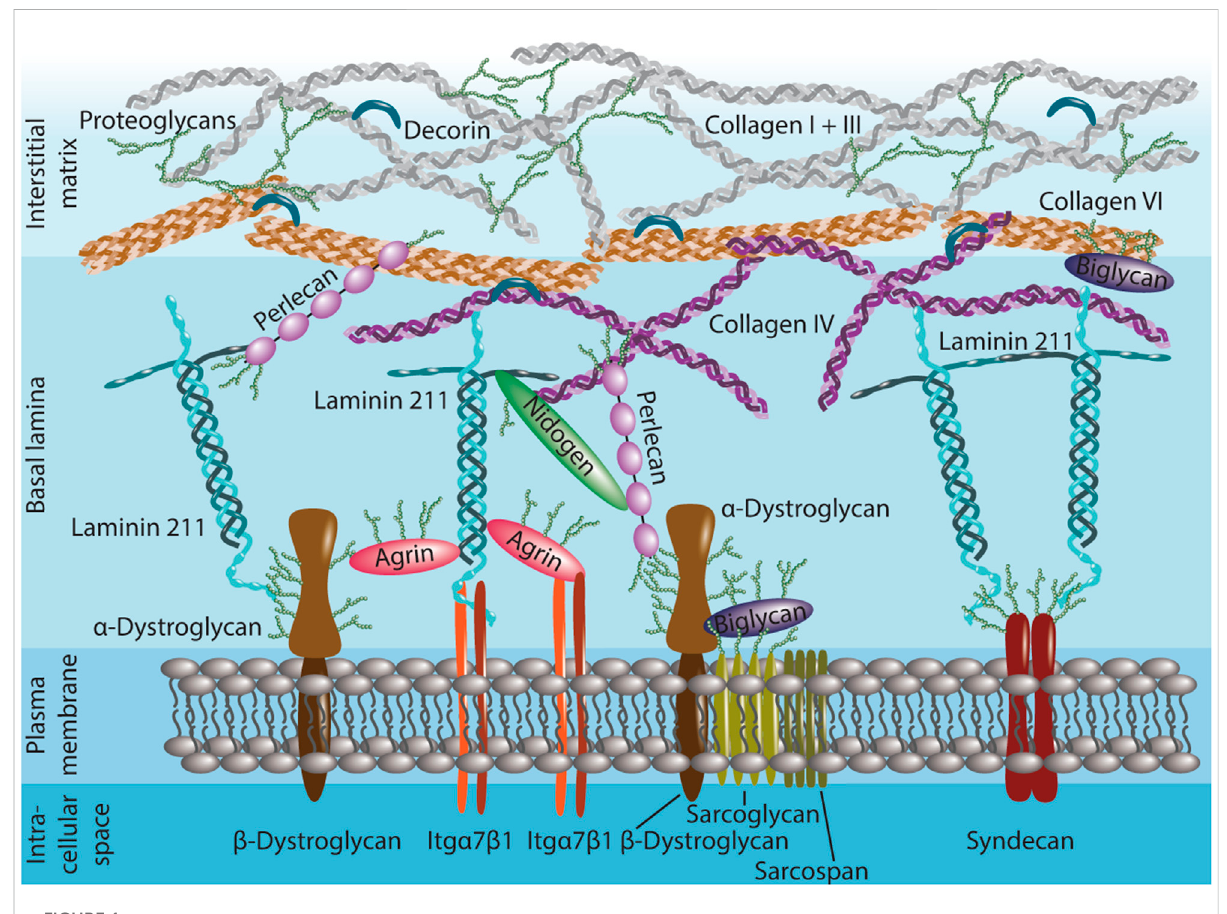
Structure of the extracellular matrix (ECM) in the quiescent muscle stem cell (MuSC) niche. MuSCs interface directly with the laminin 211 and collagen IV-rich basal lamina. Laminin 211, agrin, biglycan and perlecan interact with cell surface receptors such as dystroglycan and integrin (Itg) α 7 β 1 and connect to syndecans. Nidogen and perlecan link the collagen IV network in the basal lamina to the plasma membrane and laminin. Perlecan, biglycan and decorin help anchoring the basal lamina to collagen I, III, and VI in the proteoglycan-rich interstitial matrix. Many ECM proteins are extensively glycosylated (green